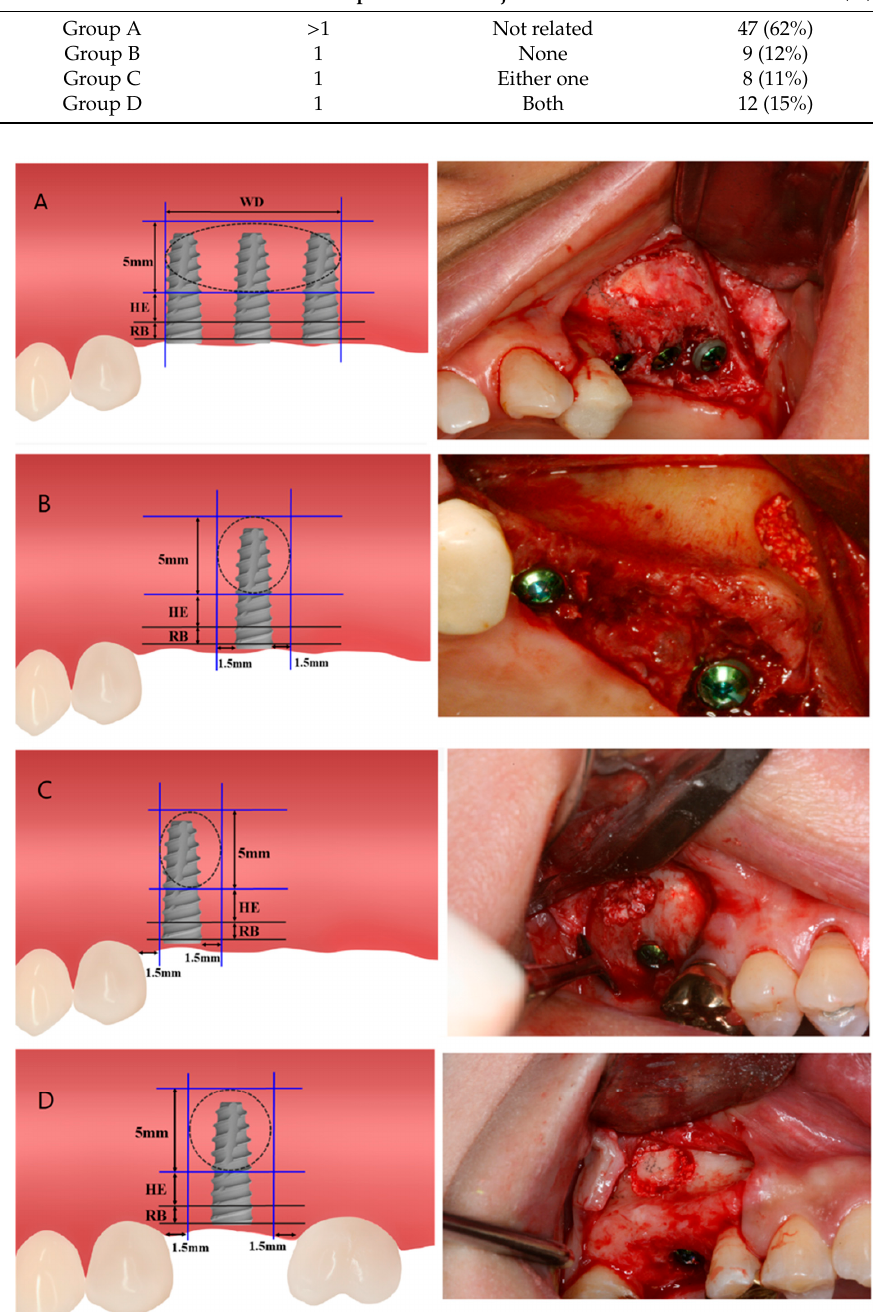
Figure 1. Diagram of the classification and related clinical photographs. ( A ) Group A. ( B ) Group B. ( C ) Group C. ( D ) Group D. RB (residual bone height): distance from alveolar ridge to inferior border. HE (vertical height for inferior border of lateral window): 3 mm when the residual alveolar bone height was 3 mm or more, and 5 mm when the residual bone height was less than 3 mm. WD (width for horizontal border of lateral window): medial border to the distal margin of the implants.